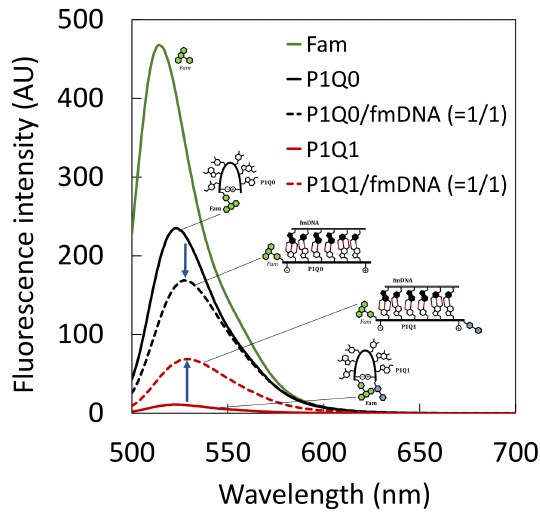
Figure 3. Fluorescence spectra of 500 nM P1Q1 and P1Q0 (red and black solid lines, respectively), and 1:1 mixtures of P1Q1 /fmDNA and P1Q0 /fmDNA (red and black broken lines, respectively). Fam was also observed as a control (green solid